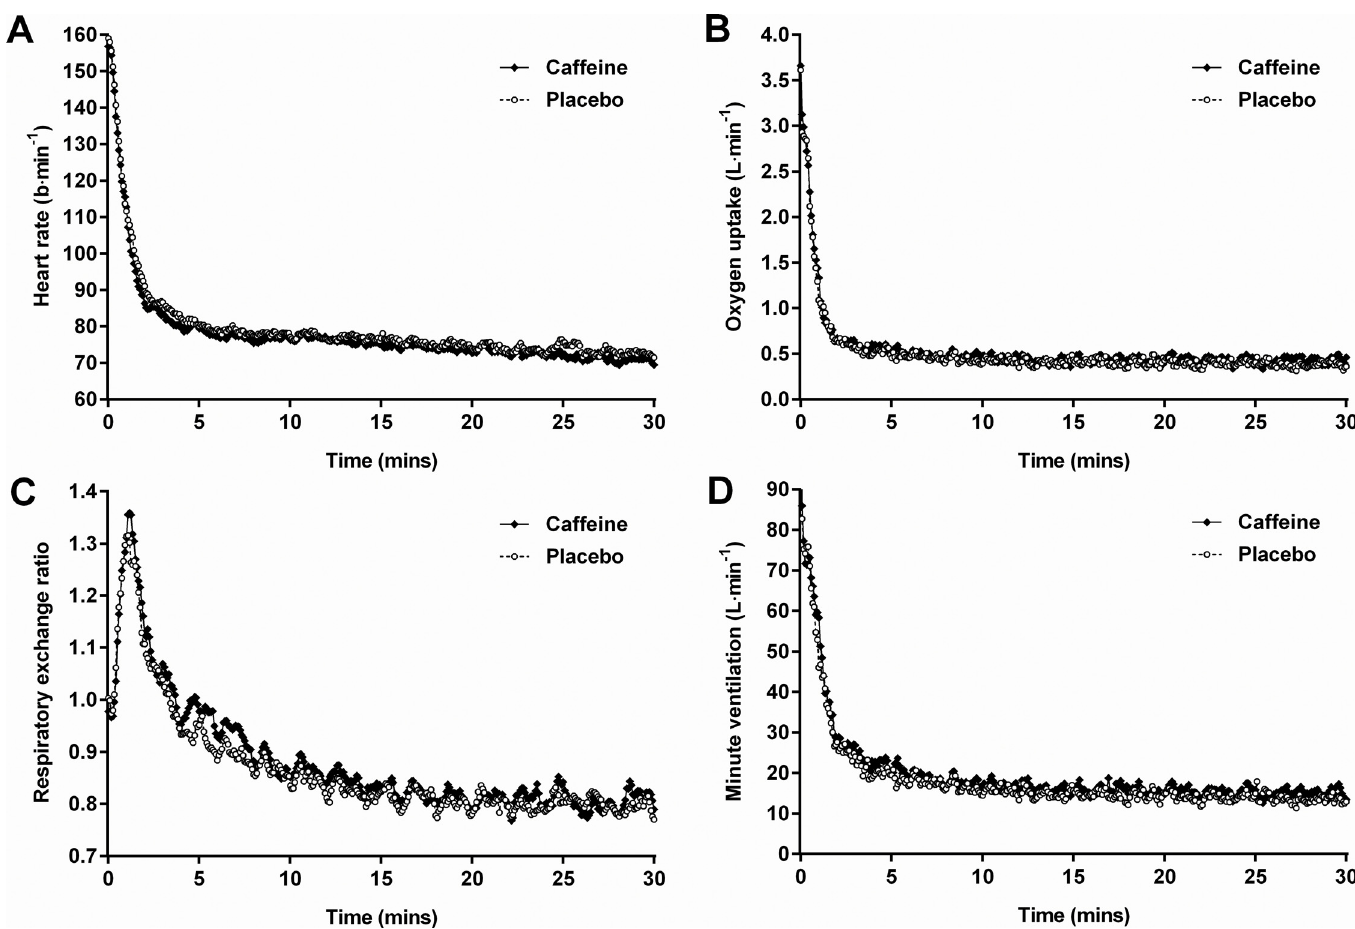
Fig 3. The effects of caffeine supplementation on heart rate (A), oxygen uptake (B), respiratory exchange ratio (C), and minute ventilation (D) measured at 5 s intervals during recovery from a bout of submaximal incremental exercise. Values are means.